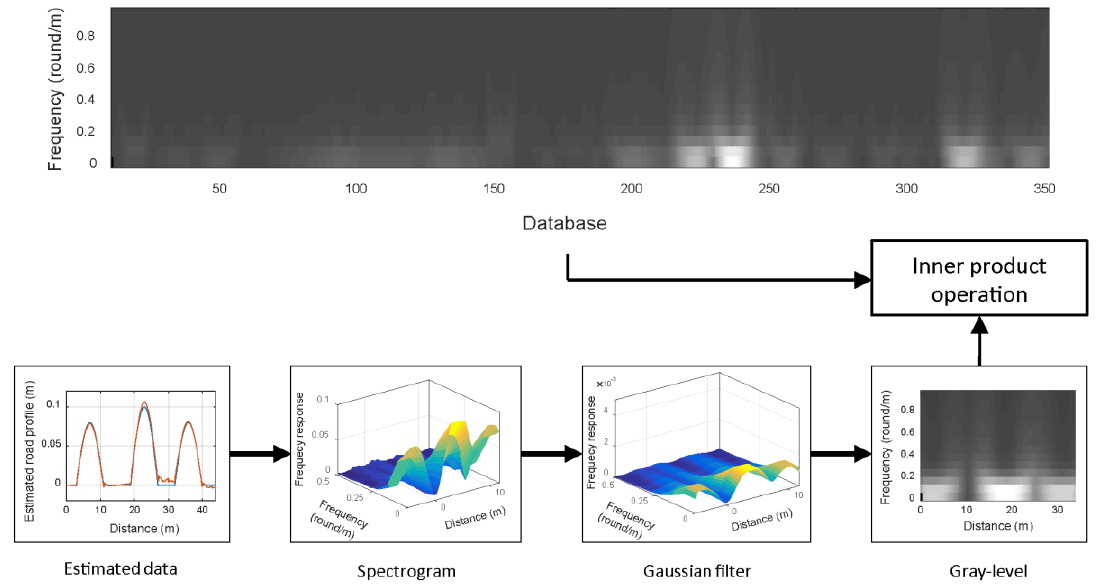
Figure 10. Normalized gray-level correlation process.